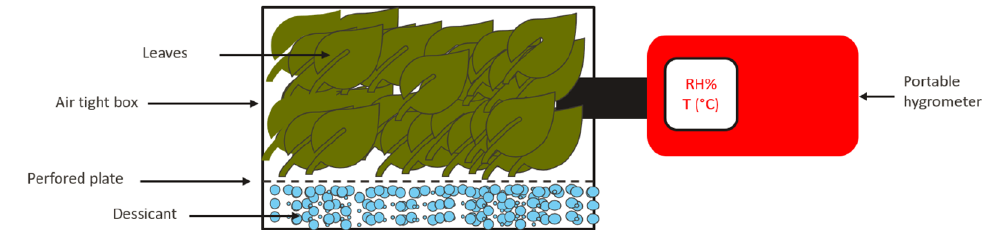
Fig. 4. Illustration of apparatus used to measure RH of the third body.